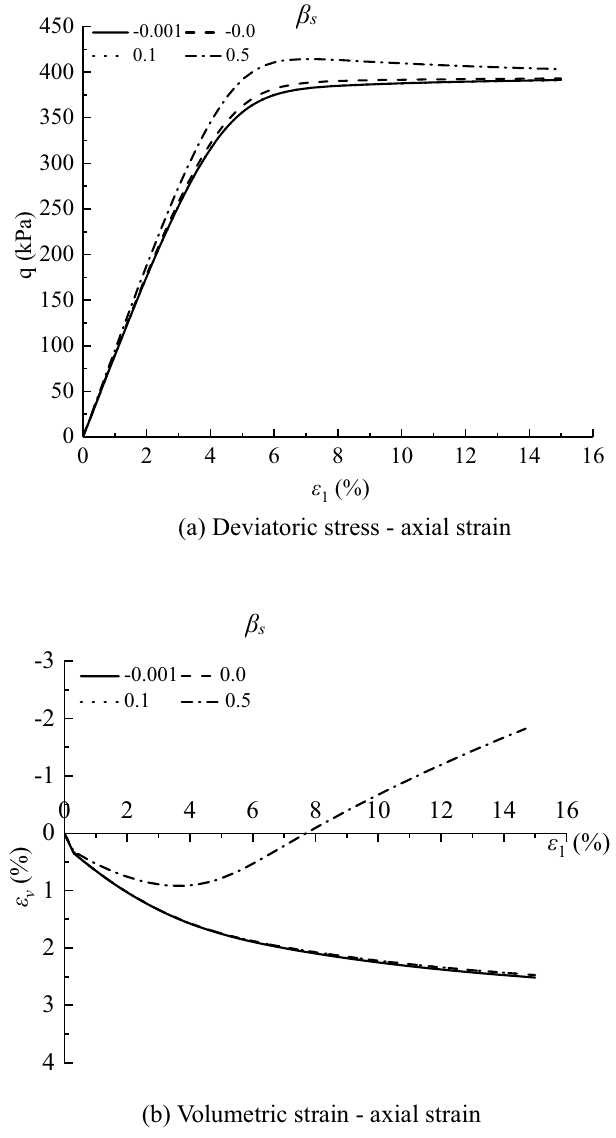
Figure 16. Sensitivity analysis of simulation results with varying β s